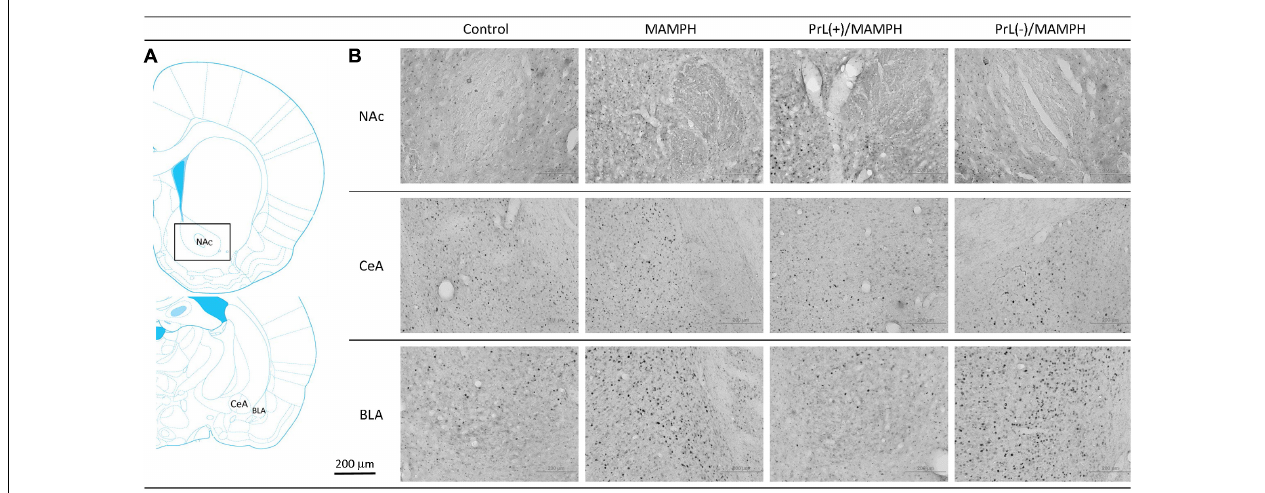
FIGURE 6 | (A) A schematic brain atlas for the NAc, and the amygdala’s CeA and BLA. (B) Representative photomicrographs of c-Fos expression for the NAc and the amygdala’s CeA and BLA in the control, MAMPH, PrL(+)/MAMPH, and PrL(–)/MAMPH groups. The scale bar represents 200 µ